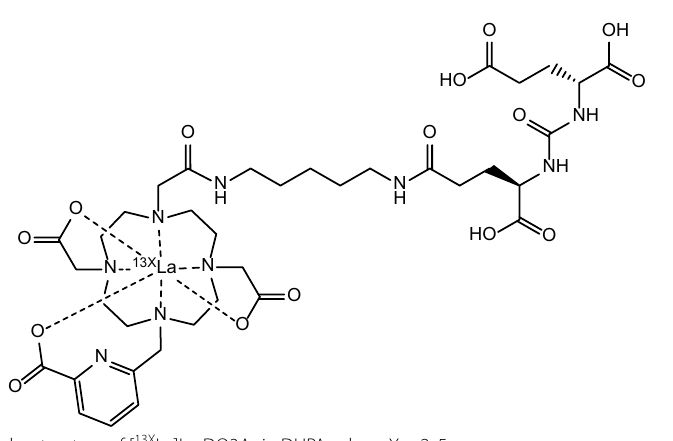
Fig. 4 Molecular structure of [ 13X La]La-DO3Apic-DUPA, where X